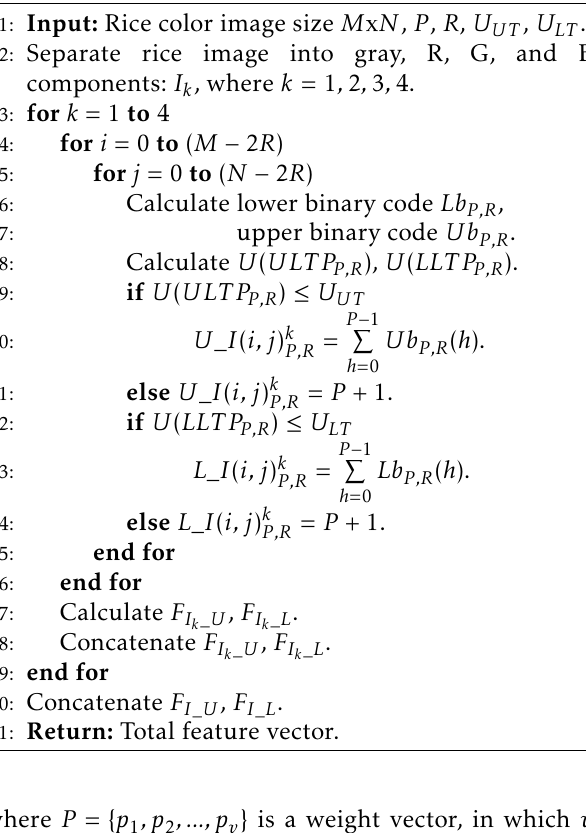
Algorithm 1 Calculating the proposed descriptor